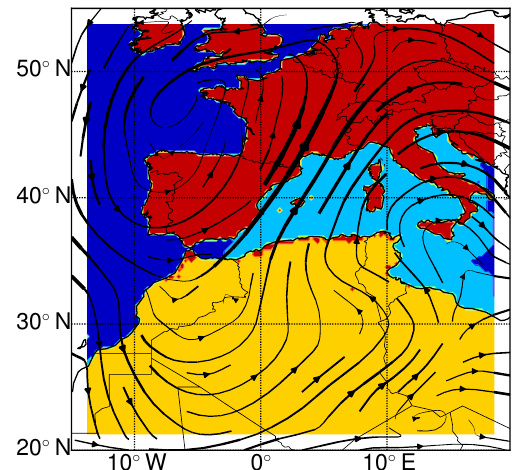
Figure 2. Aerosol mass transport as represented by the weighted vertical average (cid:104) x (cid:105) = P i w i x i / P i w i of the horizontal wind field x where weights w are given by the total dry aerosol mass concen- tration. Wind direction is indicated by arrow heads and its strength encoded in line thickness where the thickest lines correspond to 40ms − 1 . The background colors illustrate the geographic regions Africa (yellow), Mediterranean Sea (light blue), Europe (red) and Atlantic (dark blue). See main text for details of region